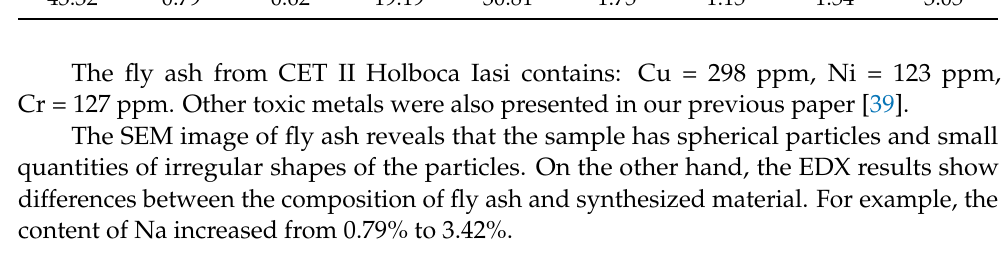
Figure 3. Influence of pH (contact time, 24 h; initial Cu 2+ concentration, 300 mg/L; adsorbent dose, 1 g/100 mL; temperature, 25 °C). 05 10 15